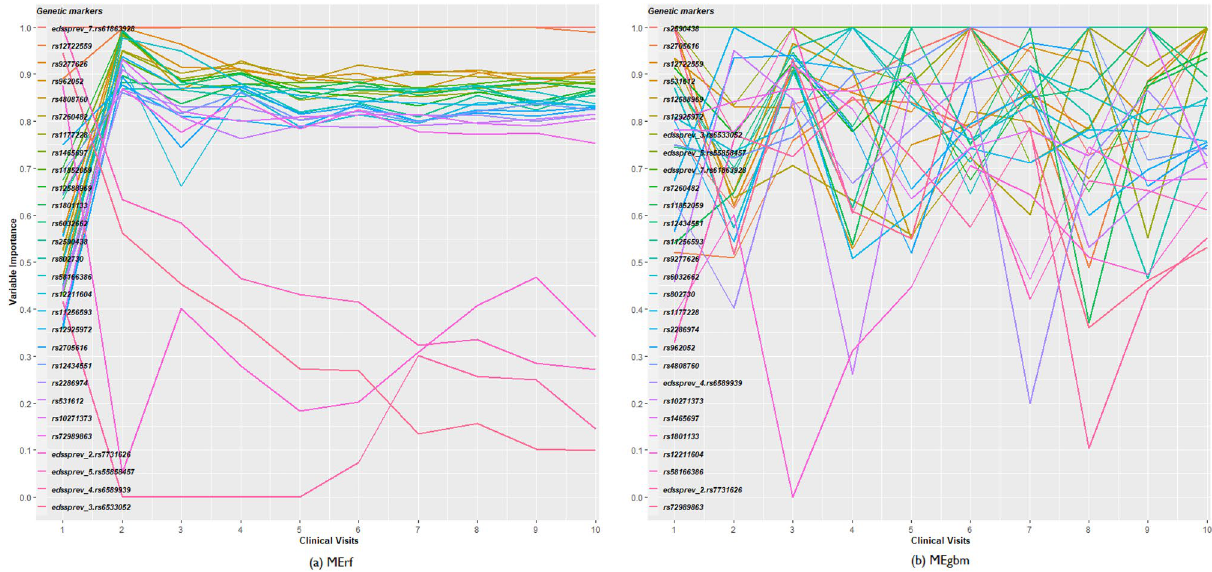
Figure 5. Ranking of genetic markers by 2 methods ( a ) MErf and ( b ) MEgbm. These curves shows the relative importance of genetic variants in predicting worsening of disability over time. Each line on the plot is a genetic marker. The color of the lines matches the color of the genetic variants. From left to right, the importance of a genetic marker in predicting worsening events changes over time (clinical visits).